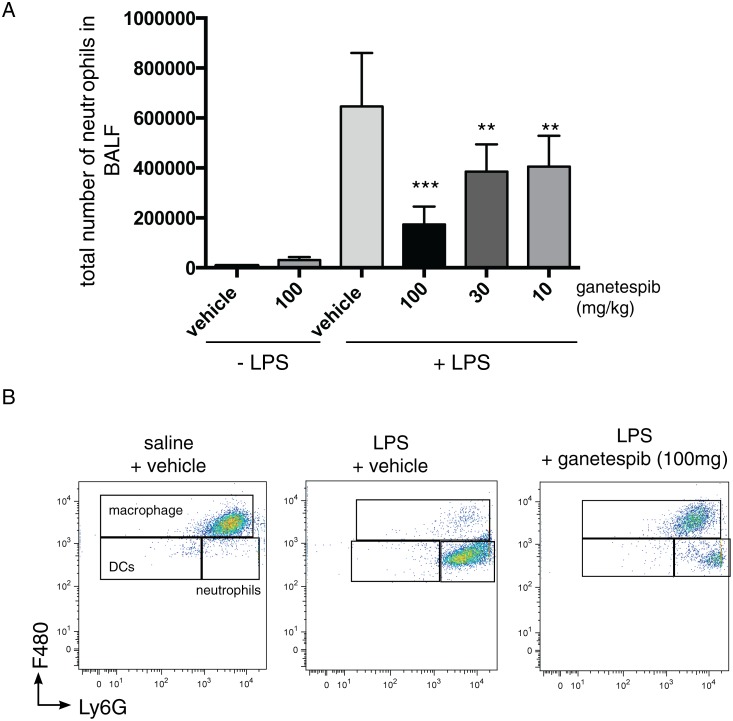
Ganetespib inhibits LPS-induced lung neutrophil recruitment.
(A) Histogram showing the total number of neutrophils in bronchoalveolar lavage fluid (BALF) of Balb/c mice treated with (+) or without (-) LPS (10 µg/mouse, tn) and/or Ganetespib at the indicated dose (mg/kg). BALF was collected 24 hours after Ganetespib administration. Data are mean ± SEM. n = 8 mice per group (100 mg/kg, no LPS; n = 4).** p<0.01 compared to LPS/vehicle treated mice. (B) Representative FACS dot plots showing the F4/80 vs Ly6G gating strategy used to defined distinct cellular subsets in BALF of mice treated with or without LPS and/or Ganetespib. Cells are PI- CD45+ and gated for large cells based on forward and side scatter properties. Plots show show 20,000–25,000 live (PI-)CD45+ cells. Note the marked suppression of neutrophil influx by GIB.